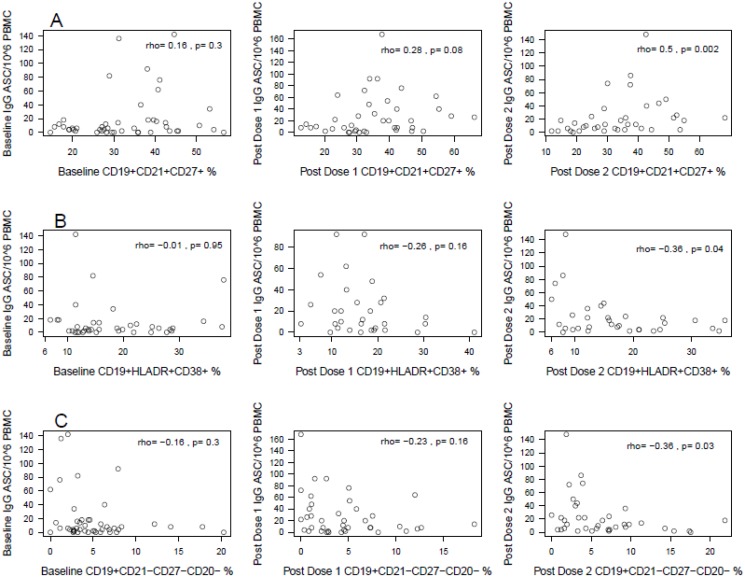
Correlations between pH1N1 Memory B Cells (IgG ASC) and Circulating B-Cell Subsets at Baseline and after Vaccination.Data are presented as scatter plots of pH1N1 IgG ASC/106 PBMCs on the ordinate and select B-cell subsets on the abscissa. Each row shows correlations of a single B cell subset: CD19+CD21+CD27+ resting memory in the top row, CD19+HLADR+CD38+ activated in the middle, CD19+CD21-CD27-CD20- tissue-like on the bottom. Columns are organized by visit: baseline on the left, post-dose 1 in the middle and post-dose 2 on the right. The correlation coefficients and p values are shown on the graphs. The data show progression of the strengths of the correlations with each dose of vaccine.